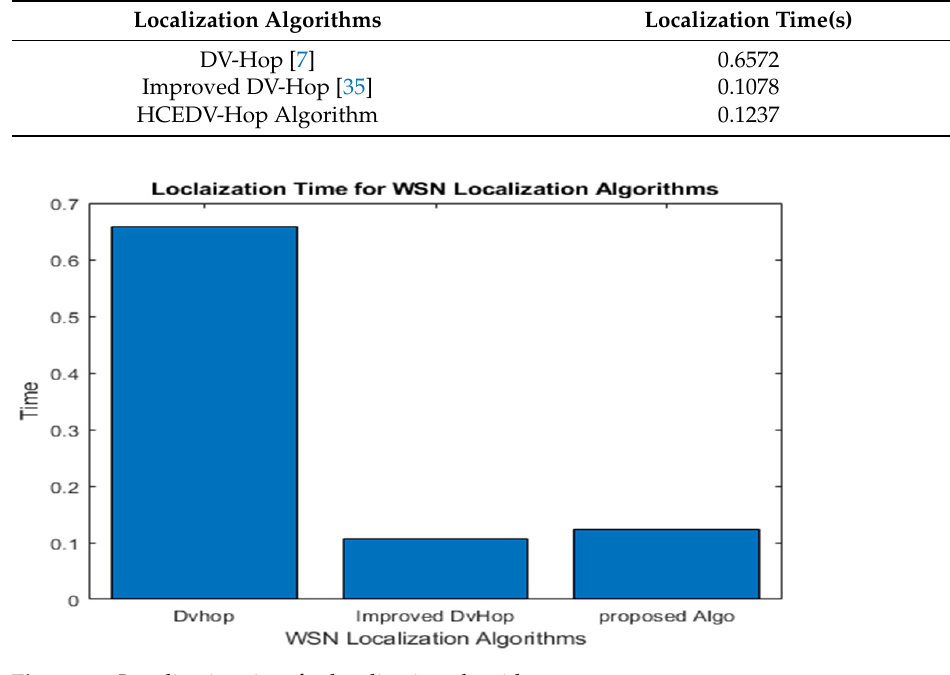
Figure 12. Localization time for localization algorithms .